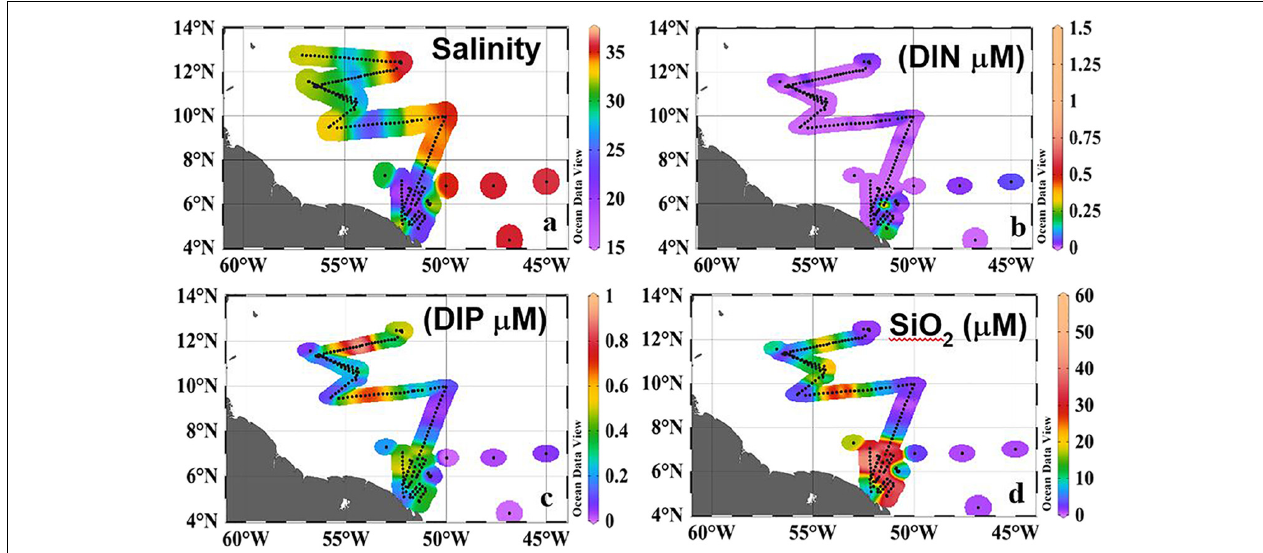
FIGURE 2 | Surface Distribution of (a) Salinity (b) Dissolved Inorganic Nitrogen (DIN, µ M), (c) Dissolved Inorganic Phosphorous (DIP, µ M), (d) Silicate ( µ M). Black dots along the track indicate sampling locations. Redrawn from Goes et al. (2014).